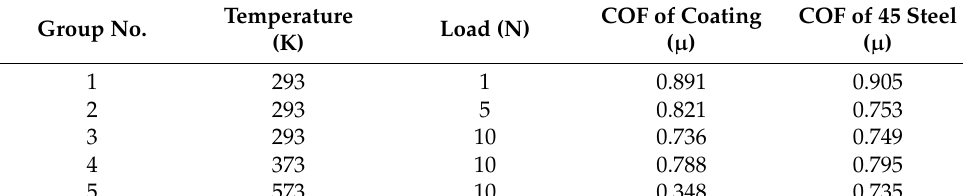
Table 2. Friction/wear test parameters and the determined average COF.